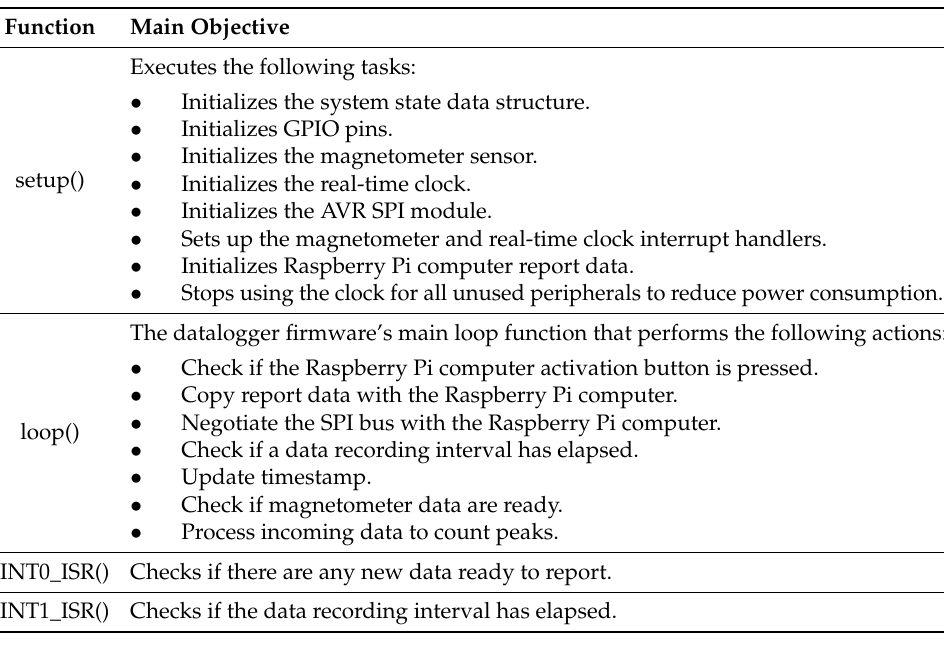
Table 3. Functions executed by the CIWS computational node Computational_Firmware.ino file and the main objective.